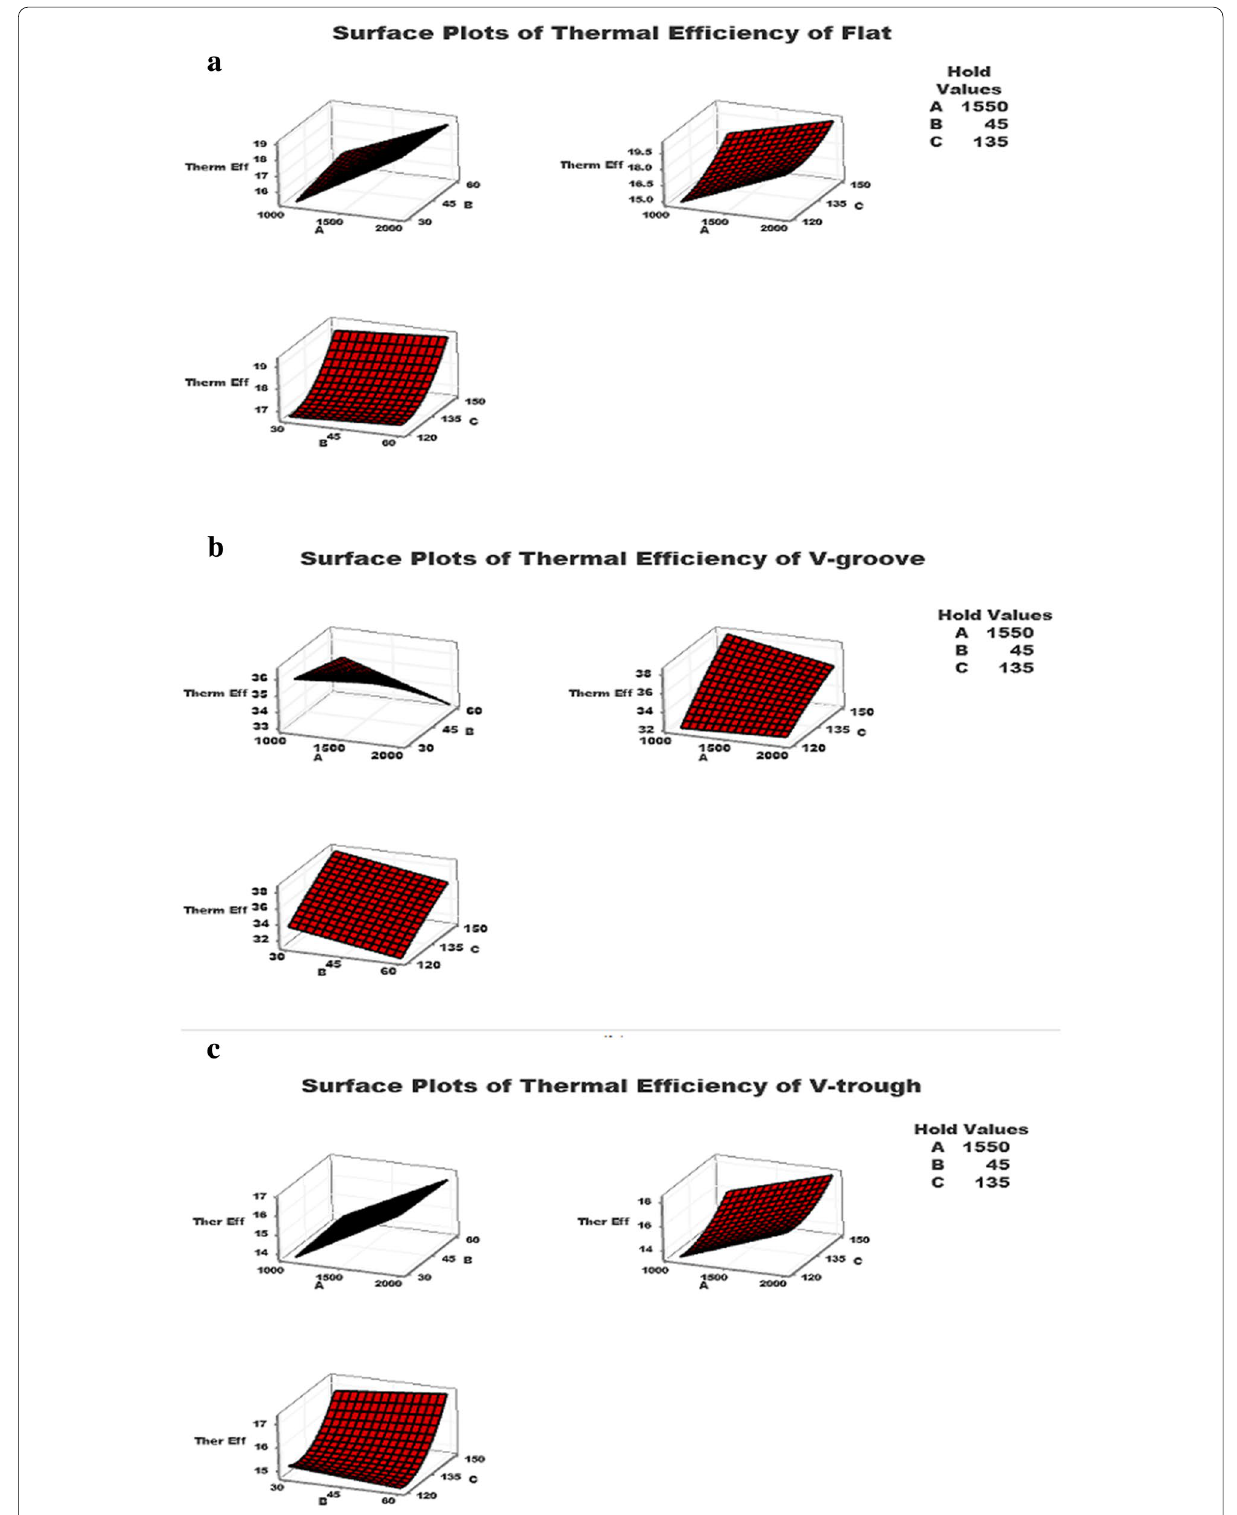
Fig. 7. 3-D surface diagram of thermal efficiency for ( a ) flat, ( b ) V-grooved, ( c ) V-trough absorber